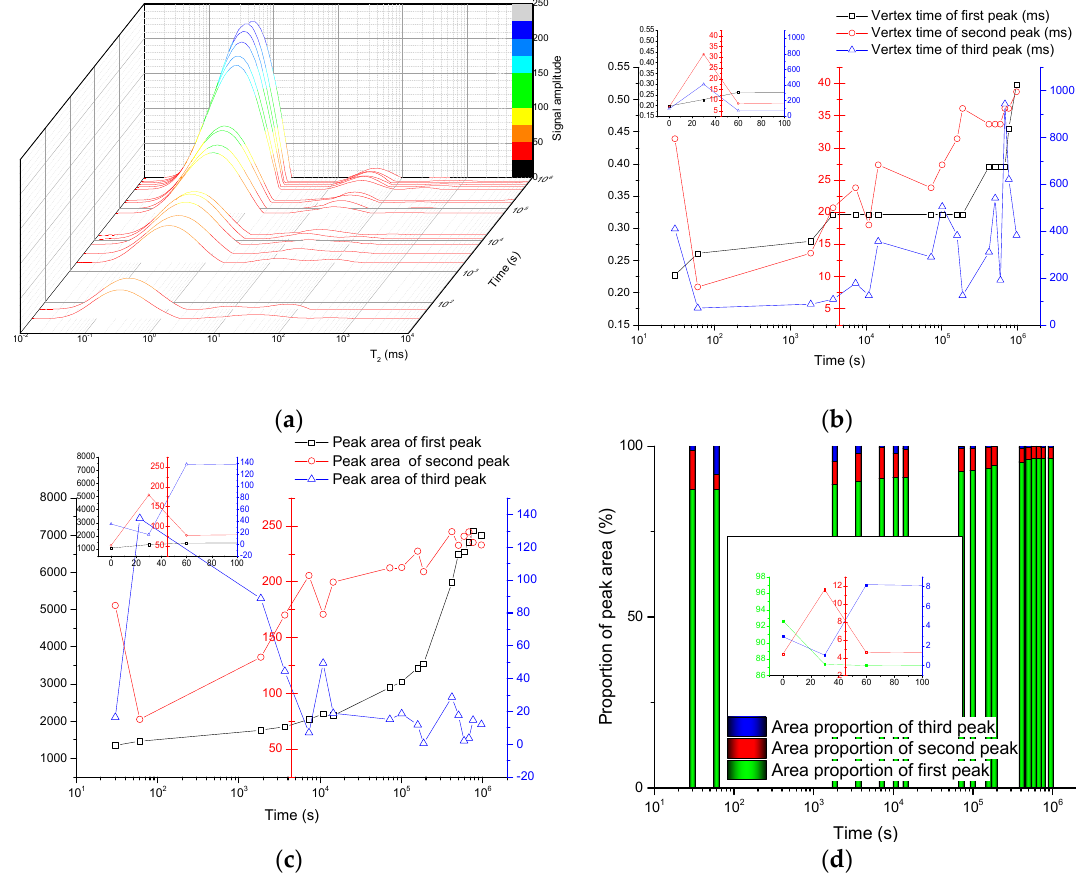
Figure 11. Spectrogram of T 2 and distribution of each peak. ( a ) Spectrogram of T 2 ; ( b ) vertex time of each peak; ( c ) peak area of each peak; ( d ) area proportion of each peak.